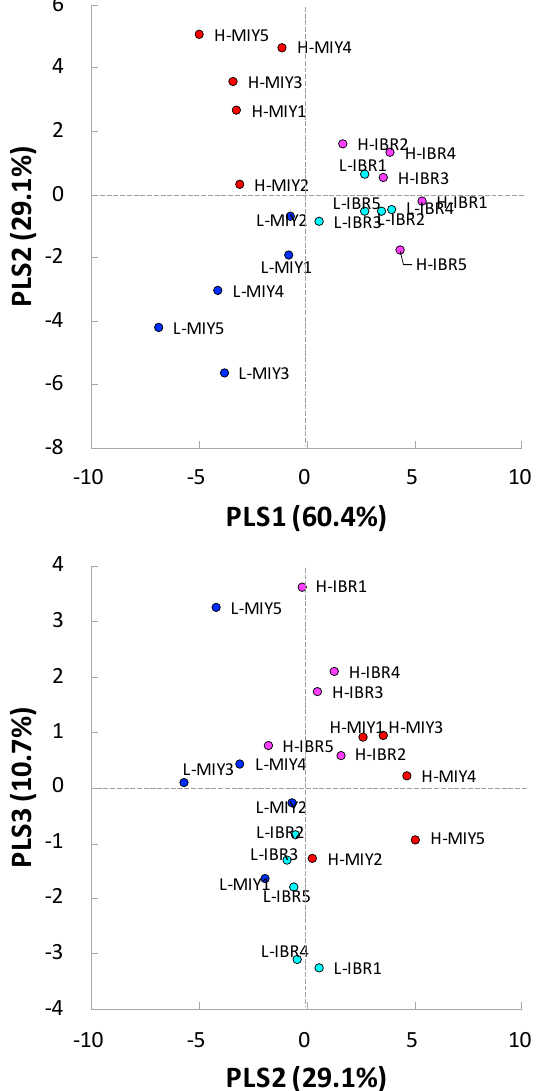
Figure 2. Integrated analyses of partial least squares by the metabolites detected from pig plasma samples showing the difference in the intramuscular fat contents at the two stations. Blue and red dots indicate low and high IMF pigs from MIY station, respectively. Cyan and magenta dots indicate low and high IMF pigs from IBR station, respectively. Top and bottom panes show the results of PLS analyses with PLS1 and 2 and with PLS2 and 3, respectively.